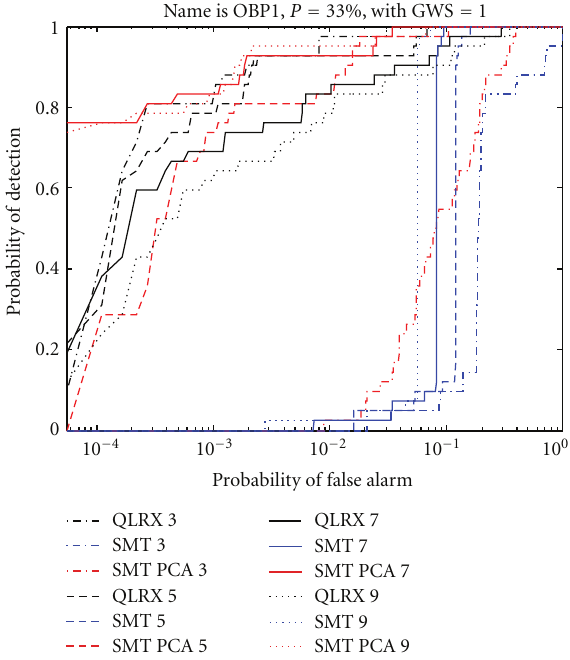
Figure 7: OBP1 results with OWS given by the number and the